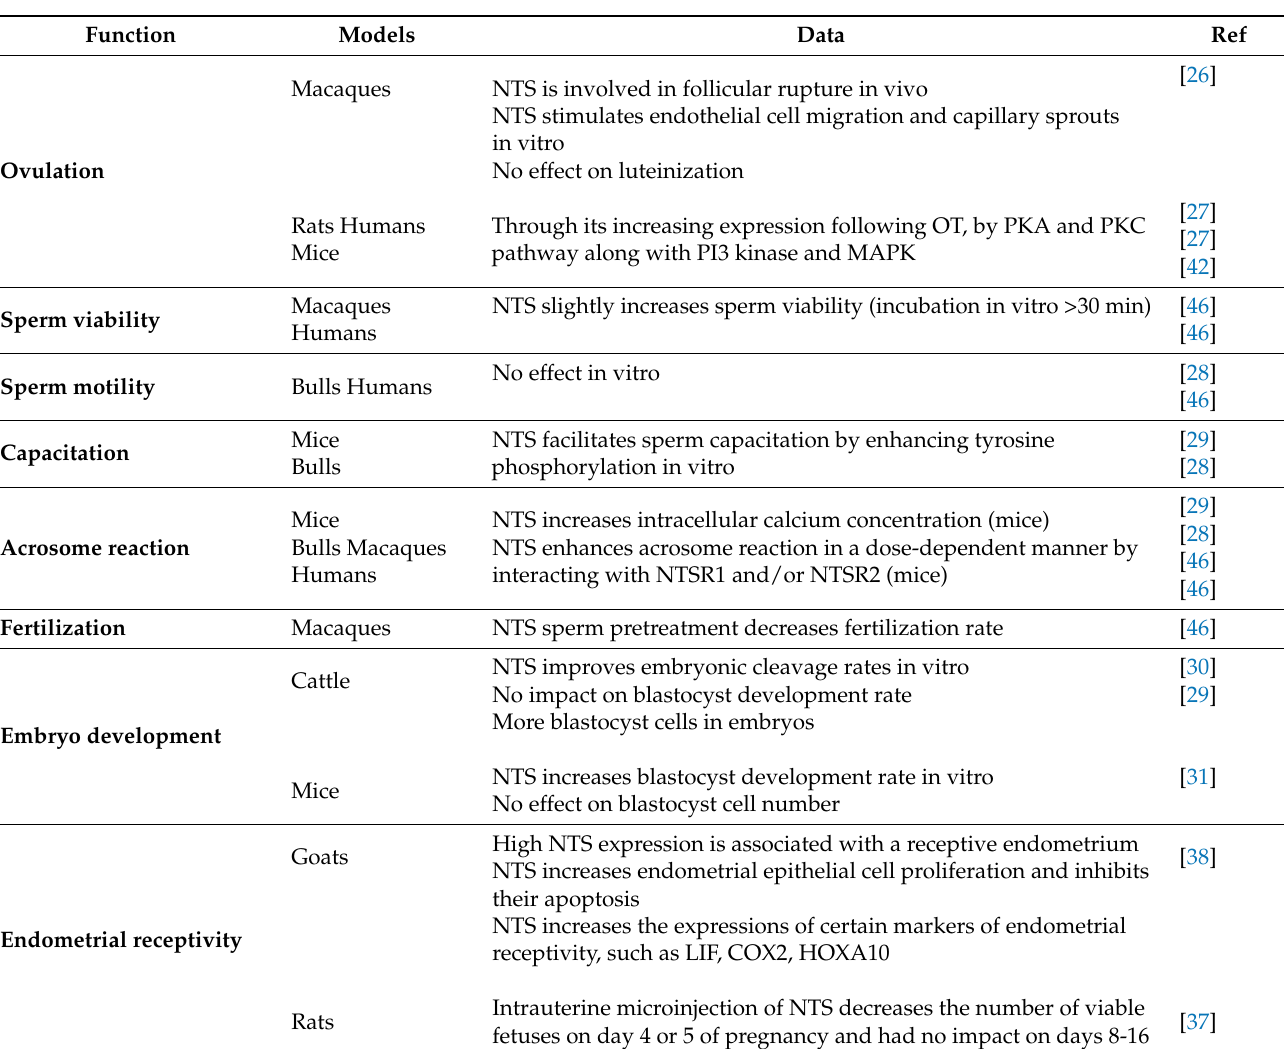
Table 2. NTS physiological functions in mammalian